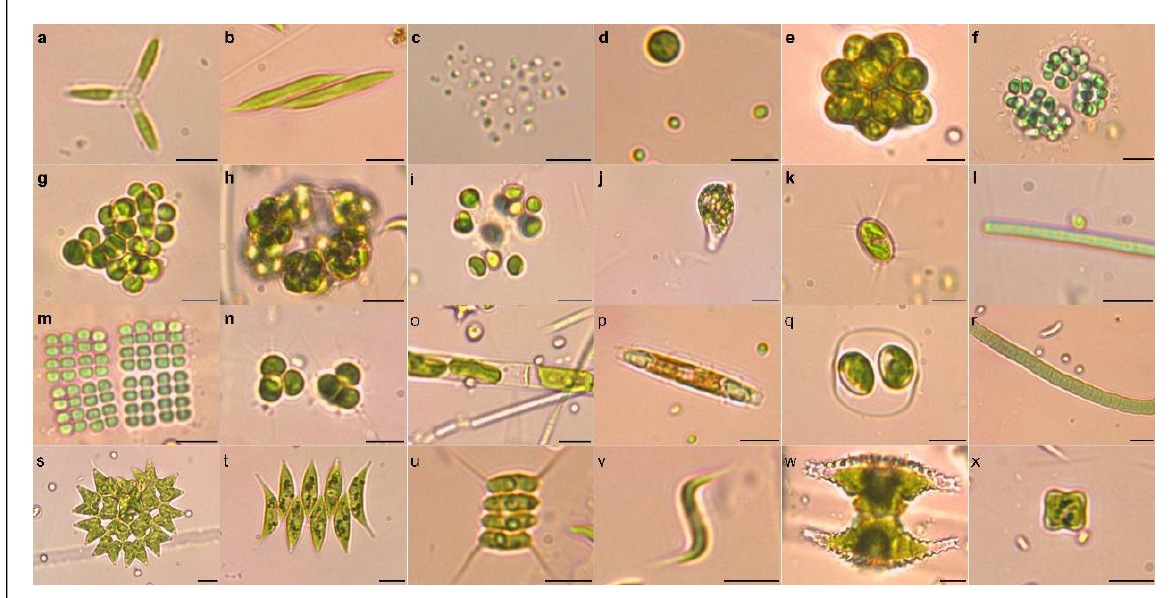
Figure 1: Micrographs of some of the identified microalgae species in the River Nile under 400×. (a) Actinastrum hantzschii; (b) Monoraphidium litorale; (c) Aphanothece smithii; (d) Chlorella vulgaris; (e) Coelastrum microporum; (f) Coelosphaerium kuetzingianum; (g) Crucigenia tetrapedia; (h) Botrydiopsis; (i) Dictyosphaerium ehrenbergianum; (j) Euglena wangi; (k) Lagerheimia ciliate; (l) Leptolyngbya fragilis; (m) Merismopedia tenuissima; (n) Micractinium pussillum; (o) Mougeotia rotundagulata; (p) Nacivula sp.; (q) Oocystis marssonii; (r) Oscillatoria sp.; (s) Pediastrum angulosum; (t) Scenedesmus dimorphus; (u) Scenedesmus quadricauda; (v) Selenastrum capricornutum; (w) Staurastrum gracile; (x) Tetraedron tumidulum. Scale bar: 10 µ m.